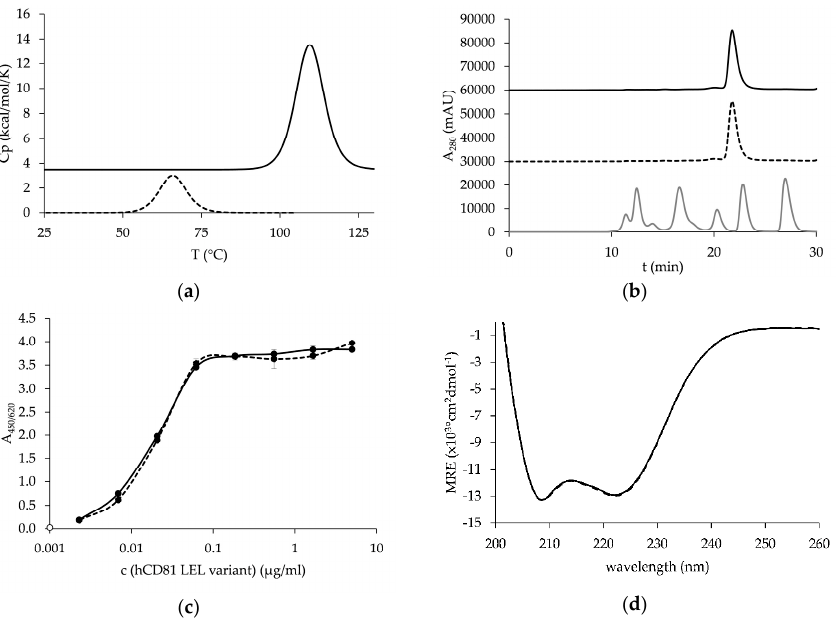
Figure 4. Characterization of hCD81 LEL_C4C9 mutant (full line) and comparison to wild-type hCD81 LEL (dashed line) with: ( a ) DSC, ( b ) SEC in native conditions (trace of the Bio-Rad molecular weight marker is indicated with a gray line and peaks correspond to 670, 158, 44, 17 and 1.3 kDa), ( c ) reactivity with M38 antibody in ELISA (signal from secondary reagent is indicated with an empty circle), and ( d ) far UV-CD.